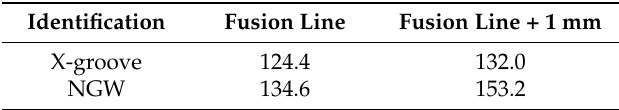
Table 5. Comparison of the Charpy notch impact test results at − 40 ◦